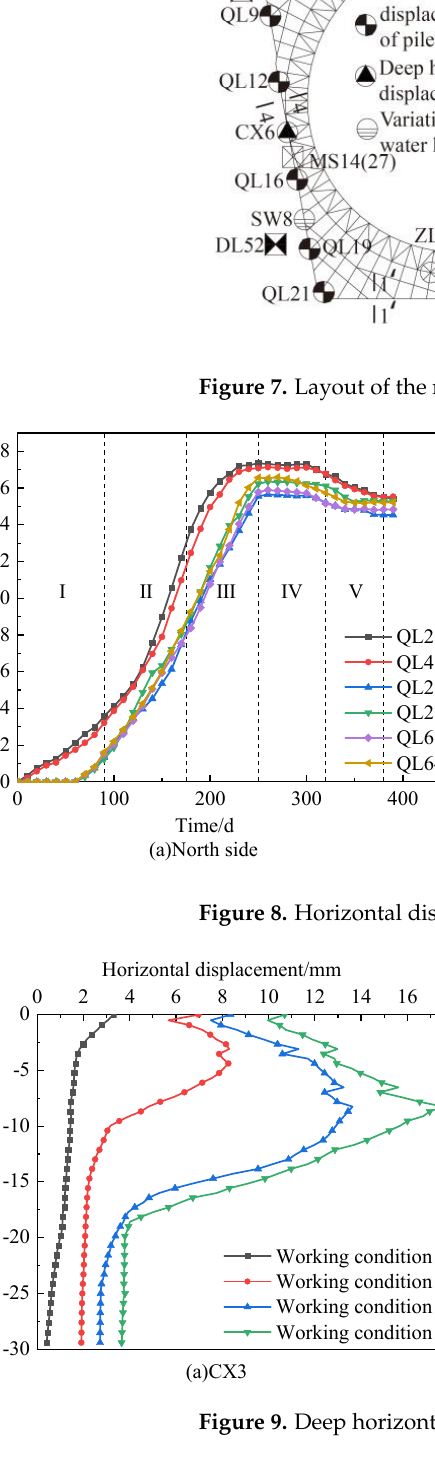
Figure 10. Change curve of the groundwater level outside the pit. Figure 11. Road settlement curve.